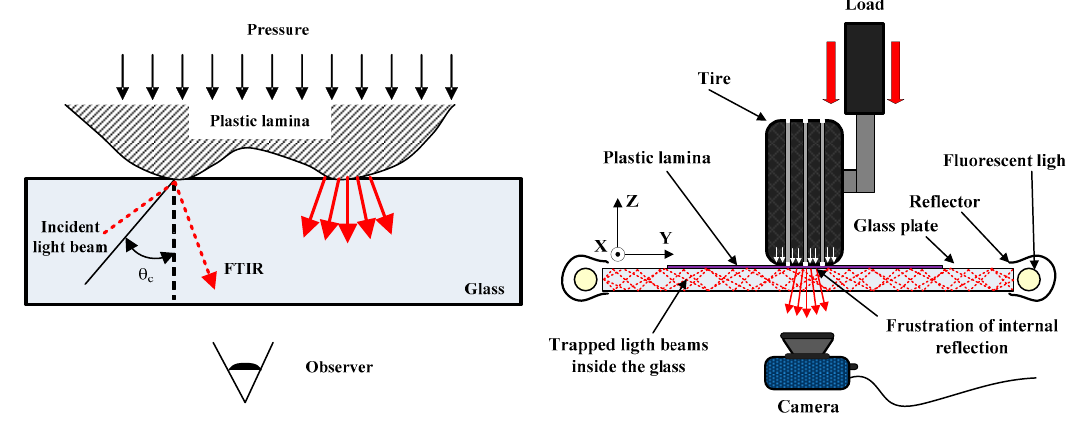
Figure 1. FTIR phenomenon ( left ); and test bench scheme ( right ).